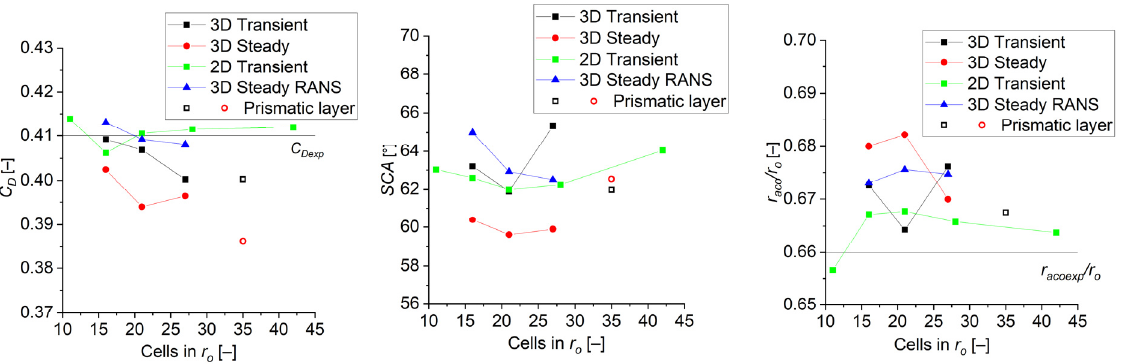
Figure 8. Mesh independence test: the effect of cell number in r o . Laminar model, Re = 2000.